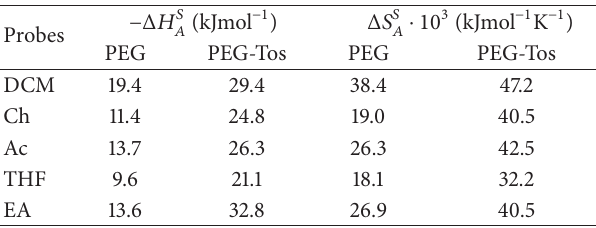
Table 3: Values of the enthalpy, Δ𝐻 𝑆 𝐴 , and entropy, Δ𝑆 𝑆 𝐴 , of adsorption on PEG and PEG-Tos for the polar probes.